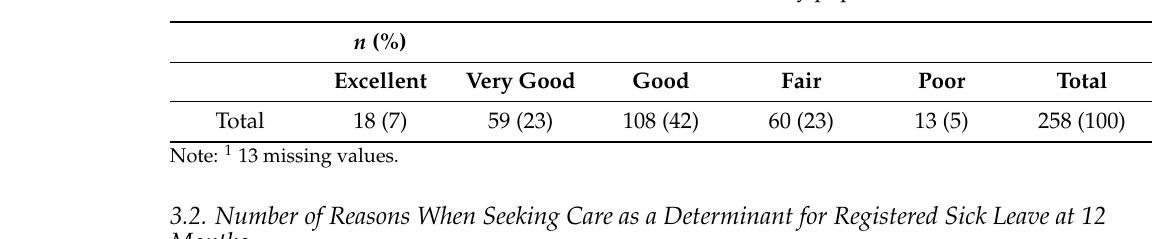
Table 3. Self-rated health at baseline, n = 258 1 for the total study